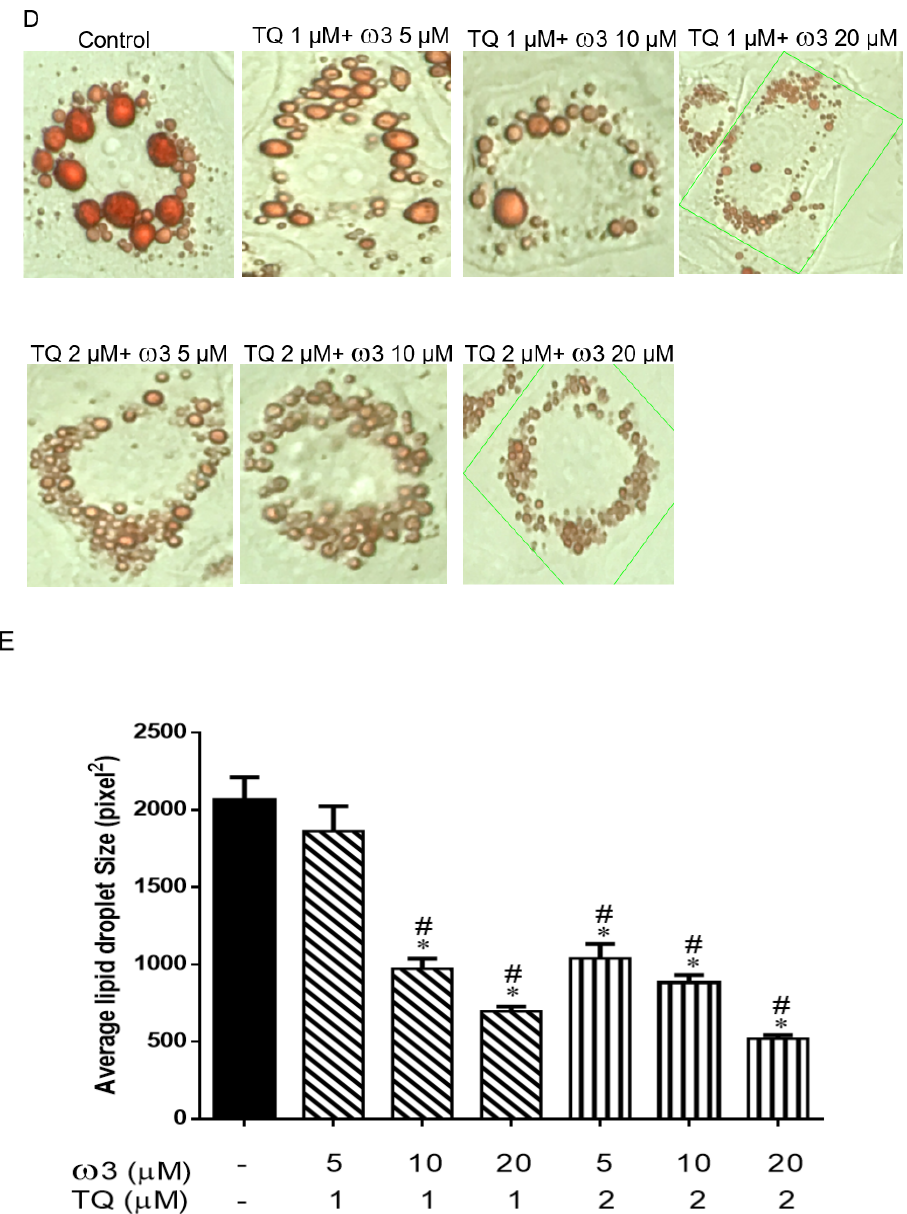
Figure 1. Scheme of the experimental protocol and dose-dependent effects of thymoquinone (TQ) and omega 3 ( ω 3) treatment on lipid droplets in 3T3-L1 adipocytes. Scheme of the in vitro and in vivo protocol ( A ). Representative and graph of the cells treated with TQ (1–4 µ M), ω 3 (5–20 µ M) ( B , C ), and a combination of TQ (1–2 µ M) and ω 3 (5–20 µ M) ( D , E ) for six days ( n = 4); * p < 0.05 vs Control; # p < 0.05 vs ω 3 5 µ M. HFD—high-fat diet;